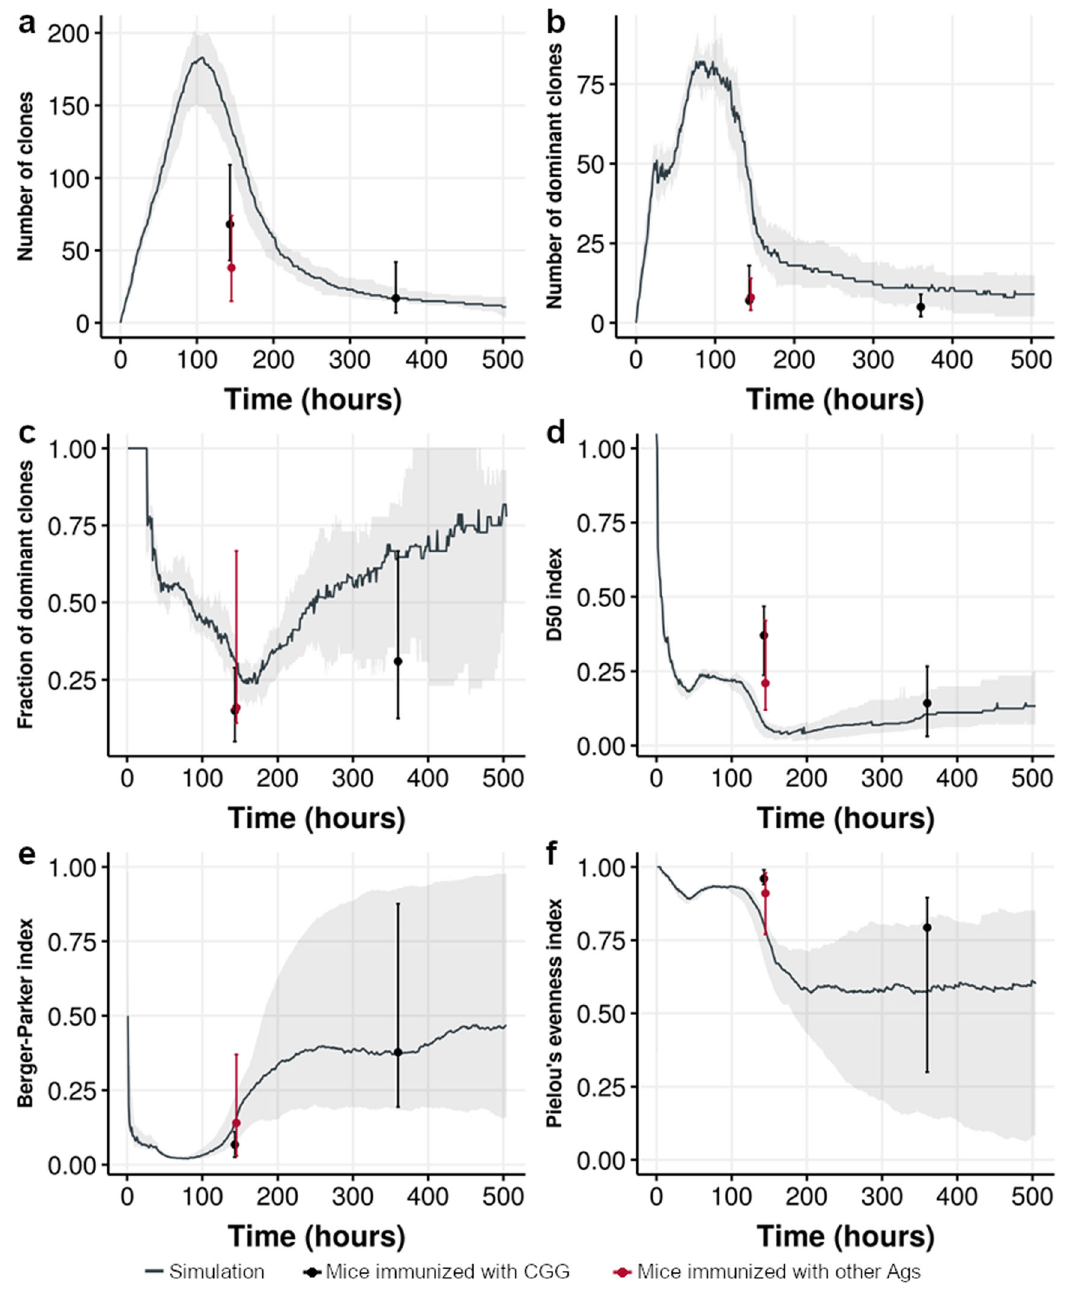
Fig. 4 Comparison of nine simulations to dataset x (single GC). Comparison showing the ( a ) number of clones, ( b ) the number of dominant clones, de fi ned as clones accounting for at least 0.5% of the repertoire; c fraction of dominant clones; d D50 index (the fraction of clones that account for 50% of the BcR sequences); e Berger – Parker index (the fraction of cells that belong to the highest abundant clone), and f Pielou ’ s evenness index (measure of the homogeneity of clone sizes ranging from 0, no evenness, to 1, complete evenness). The black curve and gray area represent the median value and observed range from nine simulations. The dot and vertical lines represent the median and observed minimum and maximum range in dataset (x) for the variable at 6 and 15 days after immunization. Vertical black line and dot represent mice immunized with chicken gamma globulin (CGG); vertical red line and dot represent mice immunized with ovalbumin, hemagglutinin or ovalbumin conjugated with 4-hydroxy-3-nitrophenylacetyl are of high af fi nity (i.e., median af fi nity above the 75th percentile). The median af fi nity of a clone is calculated under the assumption that each cell of the clone contains a single BcR sequence with a speci fi c af fi nity. Consequently, in a RNA-based repertoire the presence of PCs may skew the median af fi nity because each PC contributes with 100 sequences to the clone it is part of, compared to a B cell or MBC that only have one single sequence.